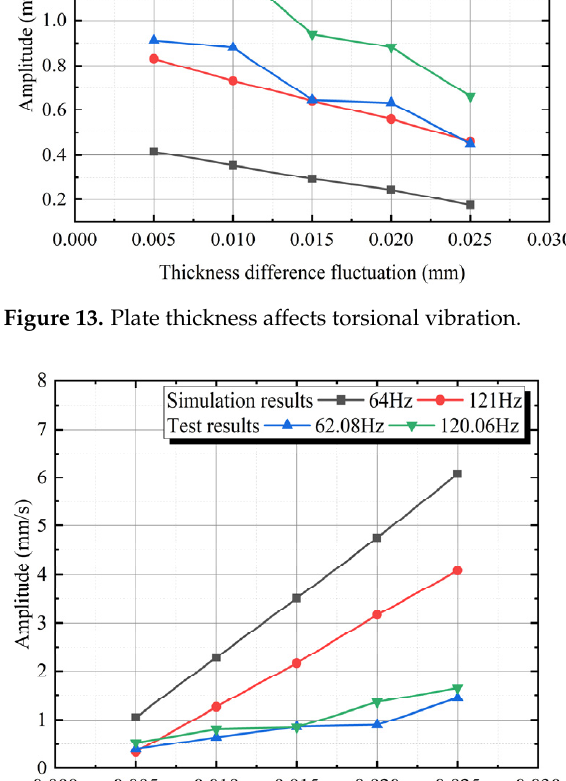
Figure 14. Plate thickness affects vertical vibration .